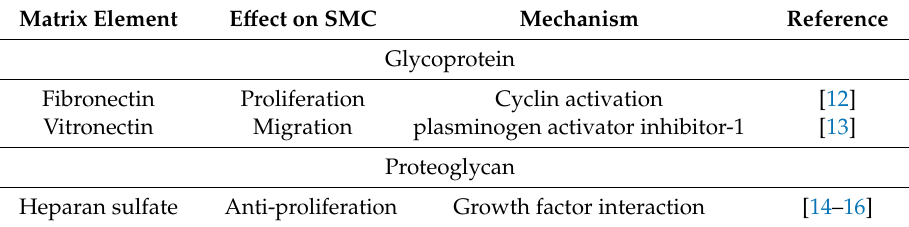
Table 1. Role of extracellular matrix (ECM) in systemic vascular intimal